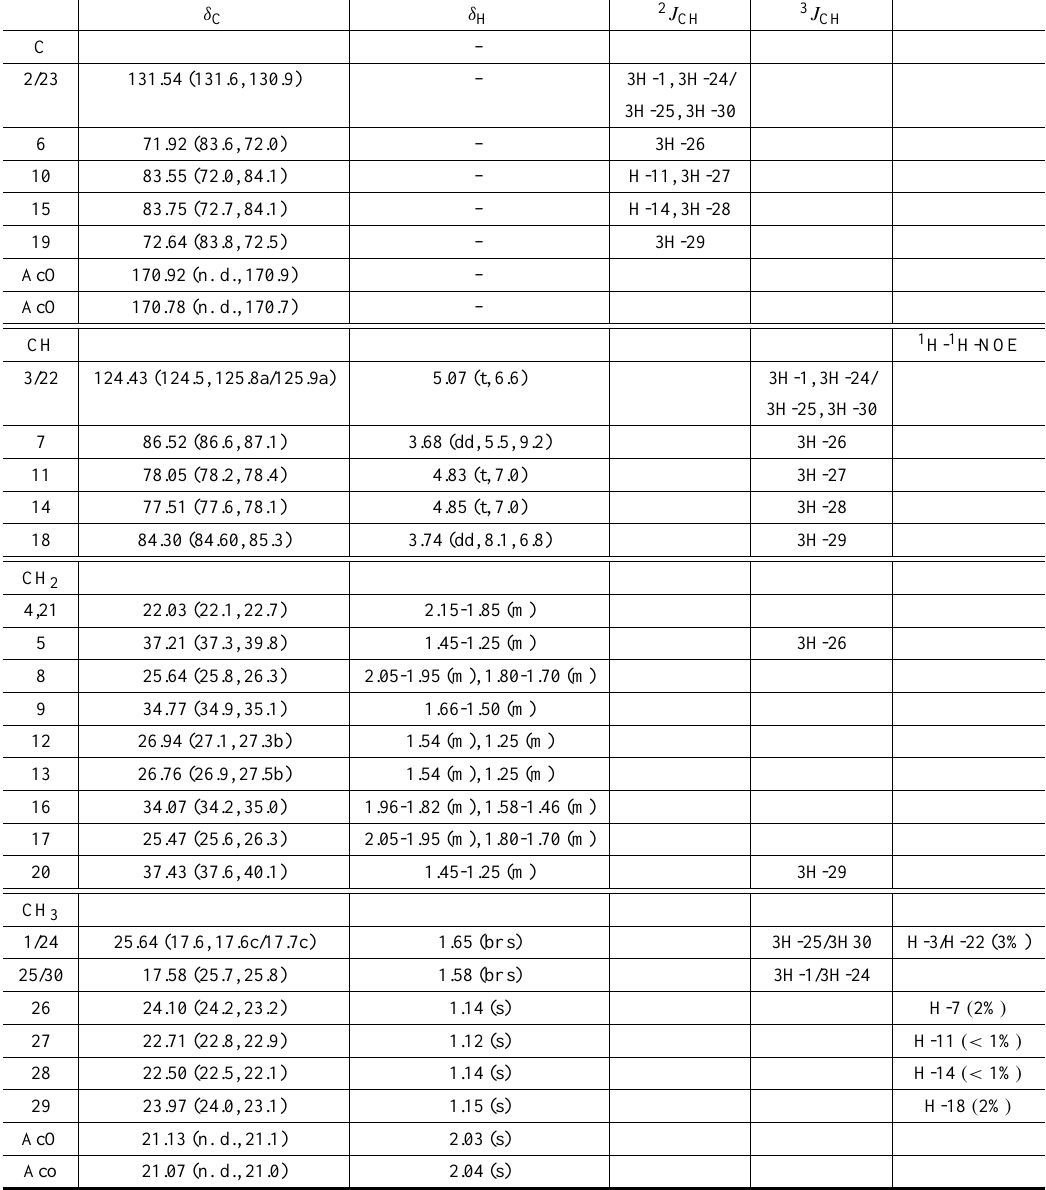
1D and 2D 1 H and 13 C NMR spectral data for compound 19, in CDCl 3 and TMS as internal standard, compared with values (in parenthesis, in CDCl 3 and pyridine- d 5 respectively) described in the literature (Itokawa et al. 1991, Morita et al. 1993) for eurylene (19). Chemical shifts in δ ( δ H and δ C , ppm) and coupling constants ( J , in parenthesis) in